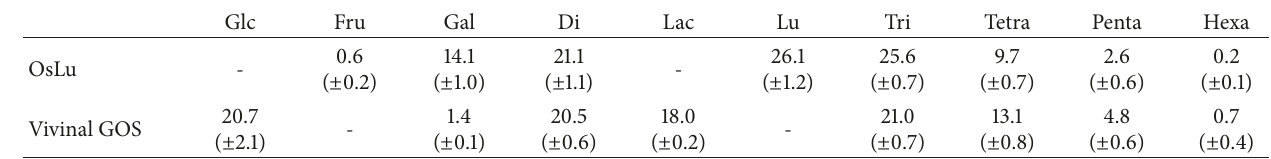
Table 1: Carbohydrate composition (% of total carbohydrates) of OsLu and Vivinal